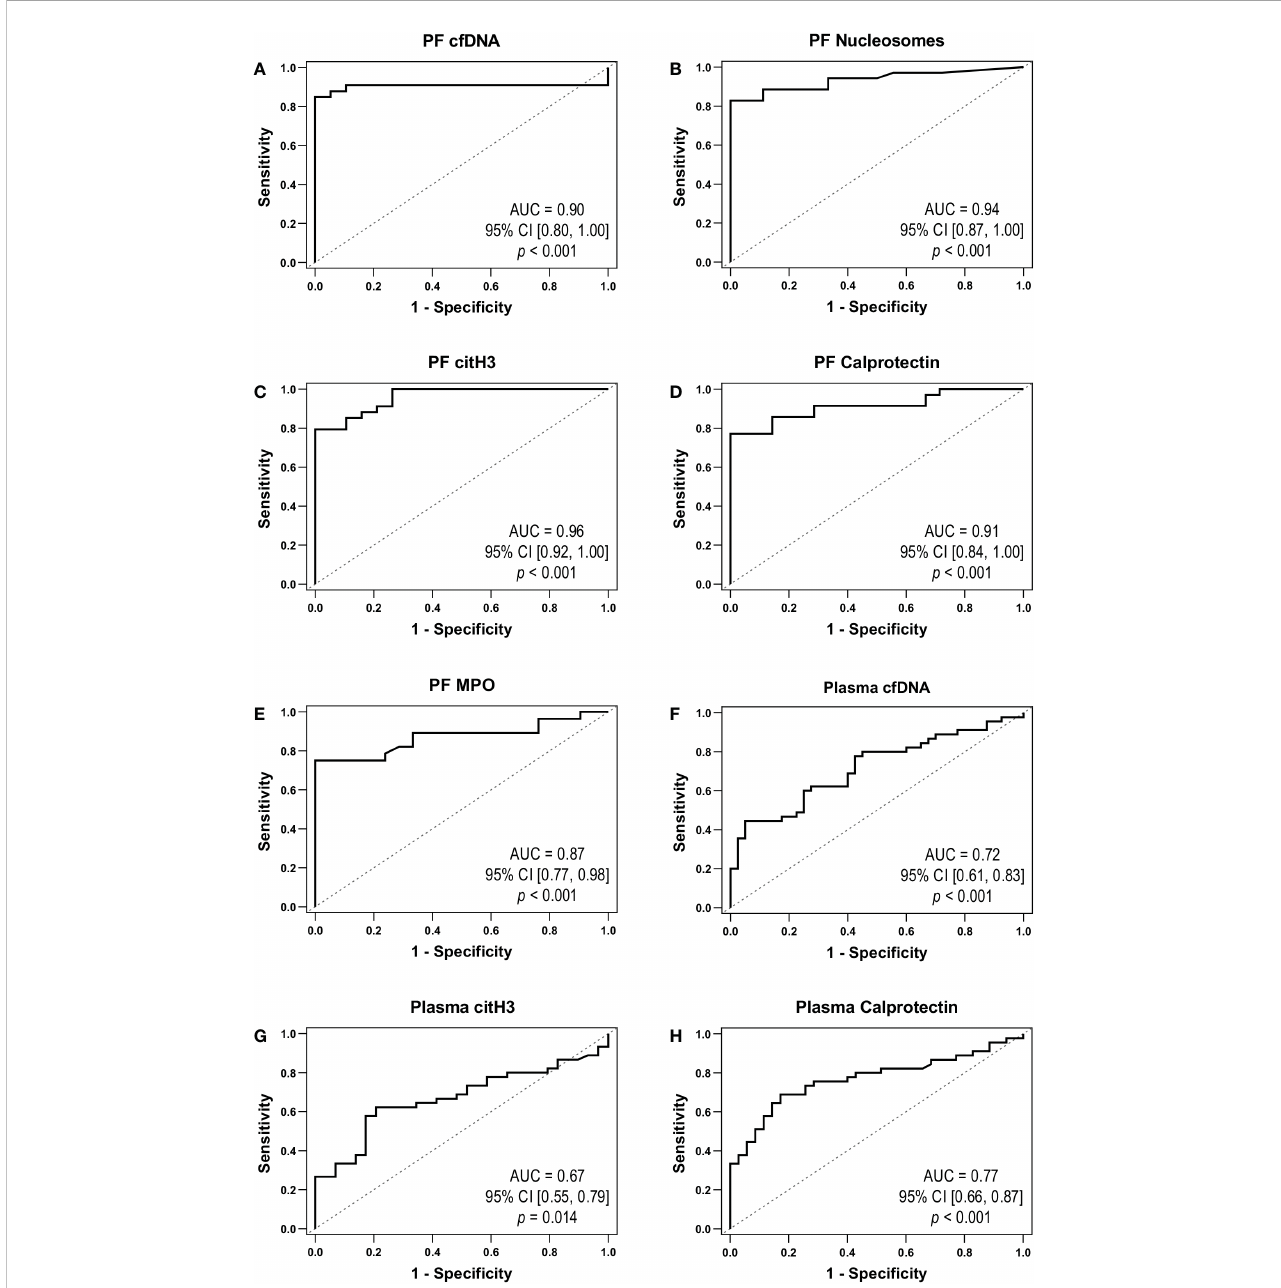
FIGURE 2 NETosis markers as biomarkers of HGSOC. ROC curves obtained for peritoneal fl uid (PF): (A) cell-free DNA (cfDNA), (B) nucleosomes, (C) citrullinated histone 3 (citH3), (D) calprotectin and (E) myeloperoxidase (MPO). ROC curves obtained for plasma: (F) cfDNA, (G) citH3 and (H) calprotectin. AUC, area under the ROC curve; CI, con fi dence